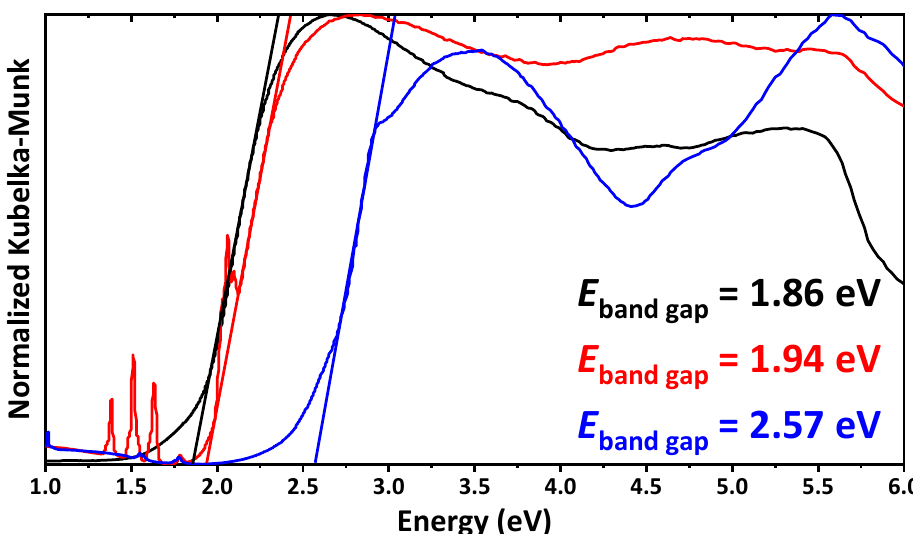
Figure 2. The IR (bottom) and Raman (top) spectra of SrLnCuS 3 (Ln = Sr, Nd, Tm).